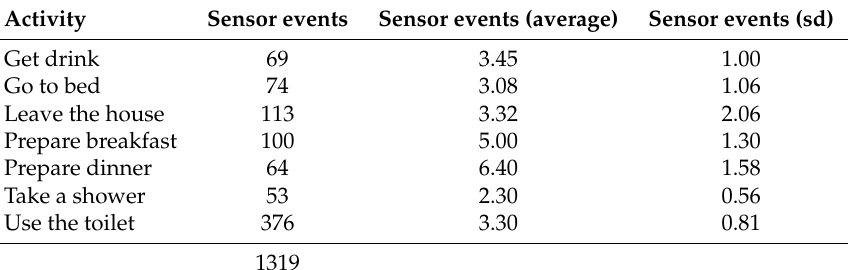
Table 4. Sensor events per activity in the